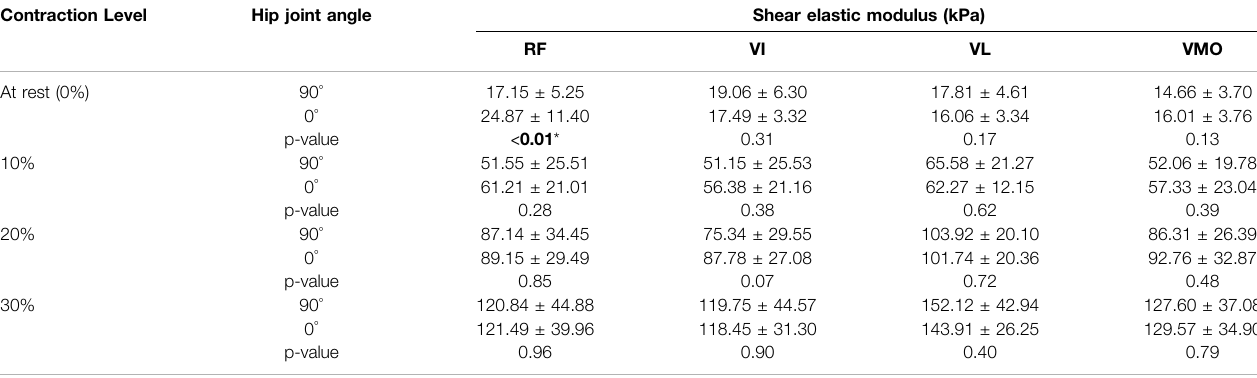
TABLE 1 | The mean shear modulus (kPa) of muscles at resting and contraction states show separately for 90 ° and 0 ° of the hip joint angles. Contraction